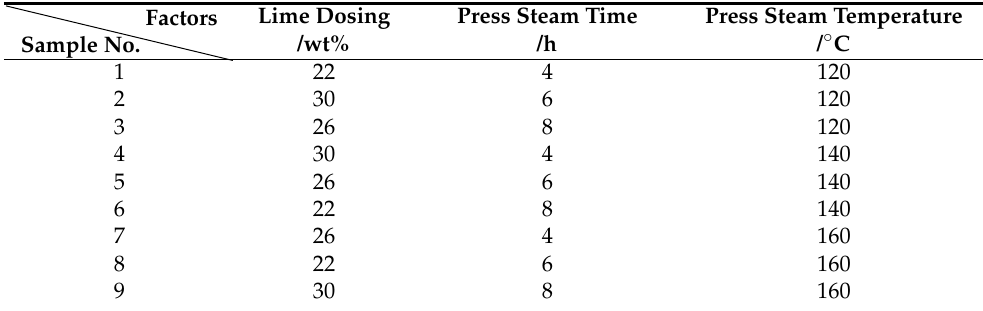
Table 2. Orthogonal experiment table-L9 (3 4 ).